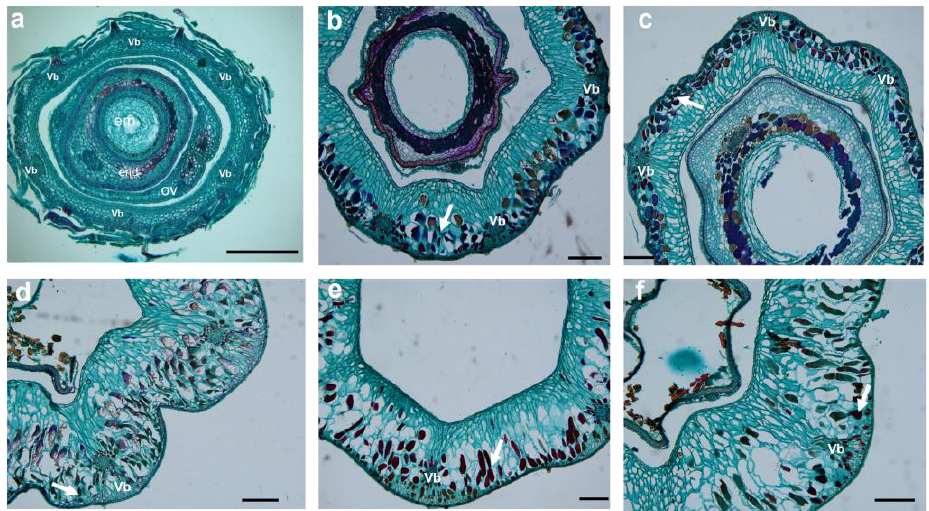
Figure 8. LM micrographs show transversal sections of H. neurocarpa fruit throughout six stages (10 DAA – 120 DAA) of growth and development. ( a ) Cellular structure at 10 DAA. Six vascular bundles were arranged circularly on the side of mesocarp cells; ( b ) Cellular structure at 30 DAA. Some cells accumulated phenolics, as indicated by the arrow; ( c ) Cellular structure at 50 DAA; ( d ) Cellular structure at 70 DAA; ( e ) Cellular structure at 90 DAA; ( f ) Cellular structure at 120 DAA. Bars = 250